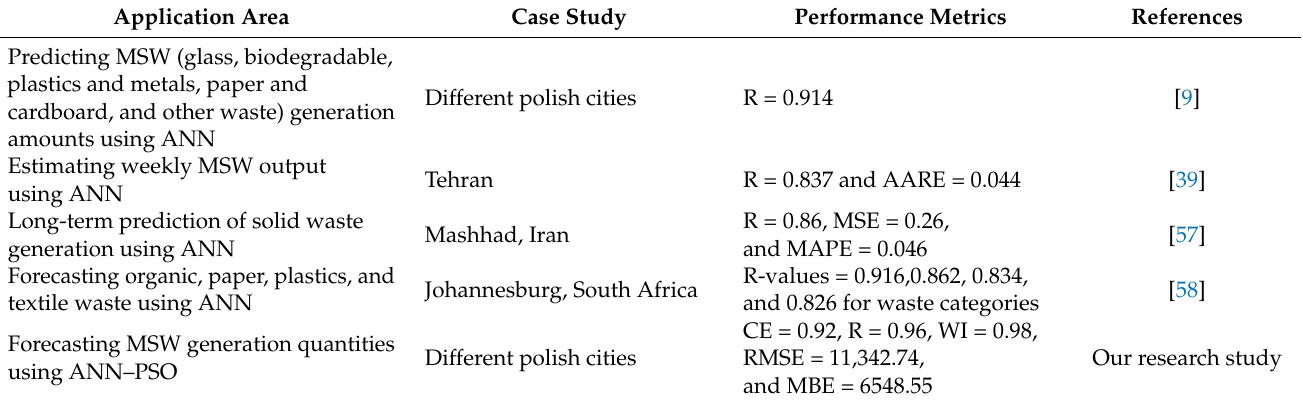
Table 4. Comparison of the outcomes of this research against the results reported in the